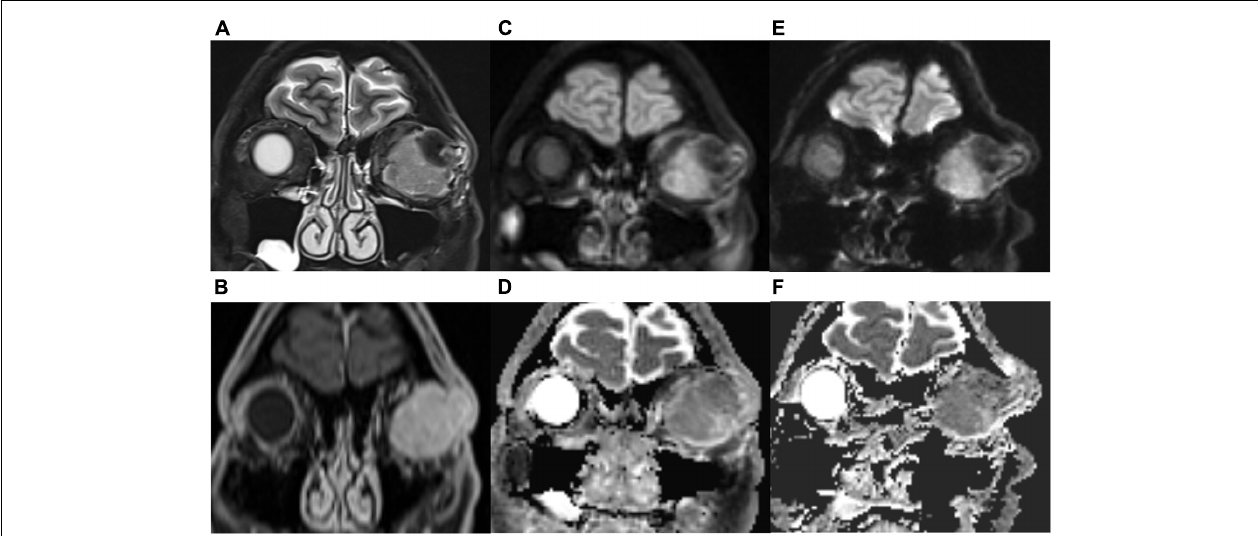
FIGURE 3 | A 50-year-old male with left solitary fibrous tumor. Compared with the T2-weighted imaging (T2WI, A ) images and contrast-enhanced T1WI (B) , this lesion could be visualized clearly with TGSE-PROPELLER-DWI b1000 (C) and ADC map (D) ; no geometric distortions were seen. Slight distortions were seen with rs-EPI b1000 (E) and ADC map (F) . More geometric distortions were observed in the frontal lobe and ethmoid sinus with rs-EPI. TABLE 4 | Correlations of TGSE-PROPELLER-DWI and rs-EPI with conventional T2WI for evaluation of orbital tumor size. Type Maximum transversal length Maximum longitudinal length * r p * r p TGSE-PROPELLER-DWI 0.986 < 0.001 0.969 < 0.001 rs-EPI 0.941 < 0.001 0.960 <